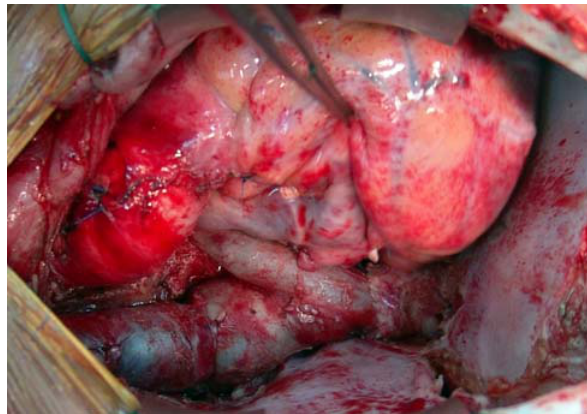
Fig. 5 – Aspecto final da operação com o tronco pulmonar anastomosado diretamente à veia cava inferior e a veia cava superior anastomosada à artéria pulmonar direita. Nota-se importante desproporção no diâmetro entre as artérias